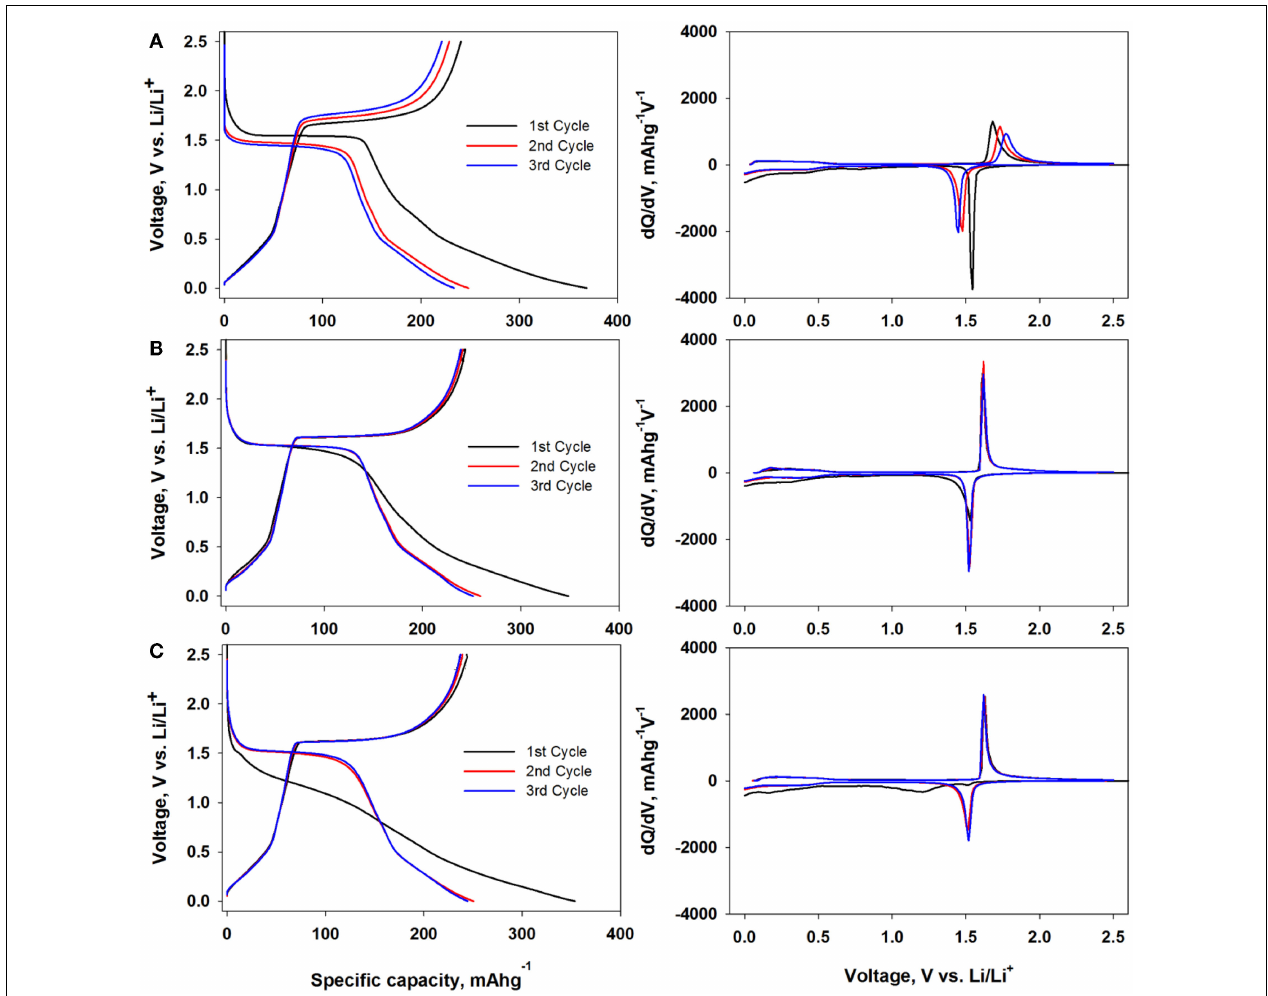
FIGURE 4 | Voltage profile (left) and differential capacity plot (right) of the bare LTO (A), 2.2nm Al 2 O 3 -coated LTO (B) and 5.5nm Al 2 O 3 -coated LTO (C) electrode with lower potential window from 2.5V to 1mV vs. Li/Li + .